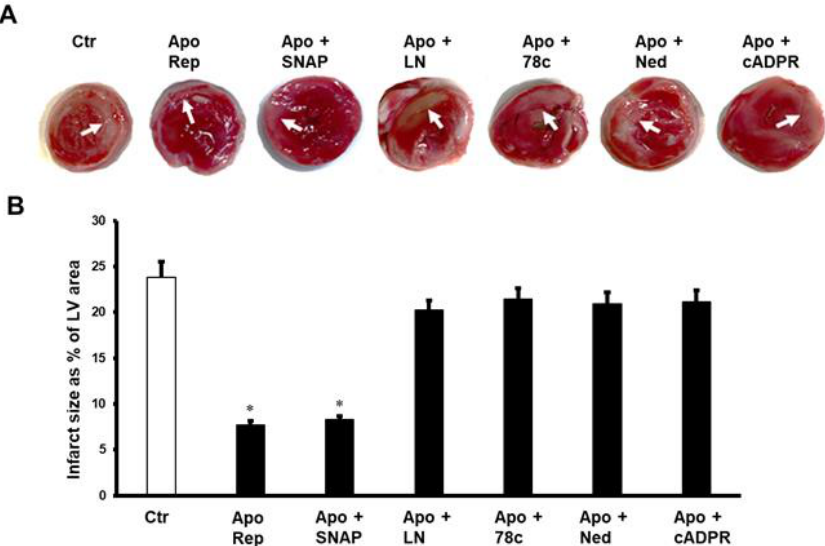
Figure 4. Infarct size as percentage of LV area after infusion of apocynin together with other inhibitors or agonists at reperfusion. Evaluation of infarct size in hearts treated with a combination of apocynin with SNAP, L-NAME, 78cr, Ned, or cADPR agonist (n = 4 per group). Data are shown as means ± SE. Ctr, controls; Apo, apocynin; SNAP, nitric oxide donor, LN, L-NAME; 78c, CD38 blocker; Ned, NAADP inhibitor; cADPR, cADPR agonist. ( A ) shows the TTC staining for the evaluation of the infarct size, and ( B ) shows the infarct size as percentage of LV area. * p < 0.05 compared to controls.